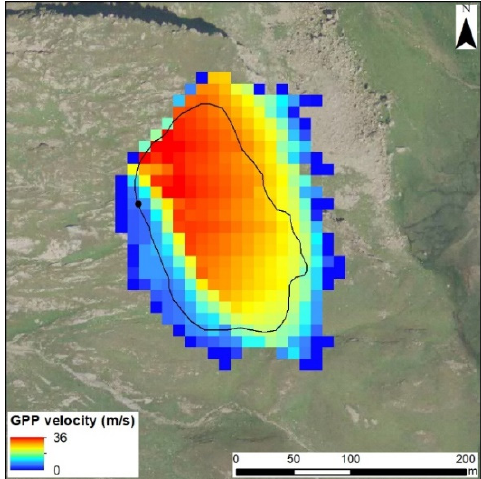
Figure 8. Velocity values of a rockfall, shown in Figure 7, obtained by the GPP model. The continuous black line corresponds to the landslide boundary, and the black point to the release reference point according to the IFFI inventory.